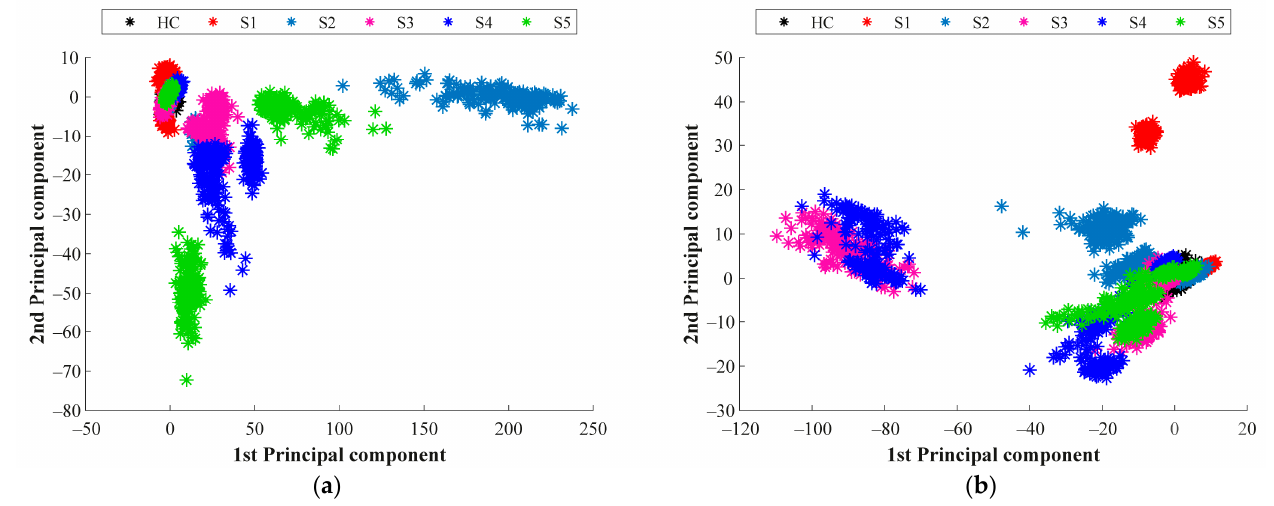
Figure 7. Two - dimensional PCA projection performed over all considered conditions: HC, S1, S2, S3, S4, and S5, and applied to the statistical features estimated from vibration signals in both analysis domains: ( a ) DT and ( b ) DF.